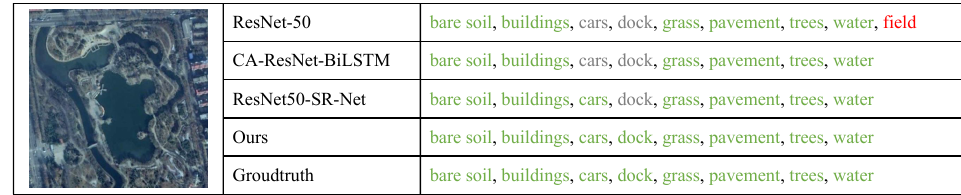
Figure 9. Qualitative results on the AID Multi-label